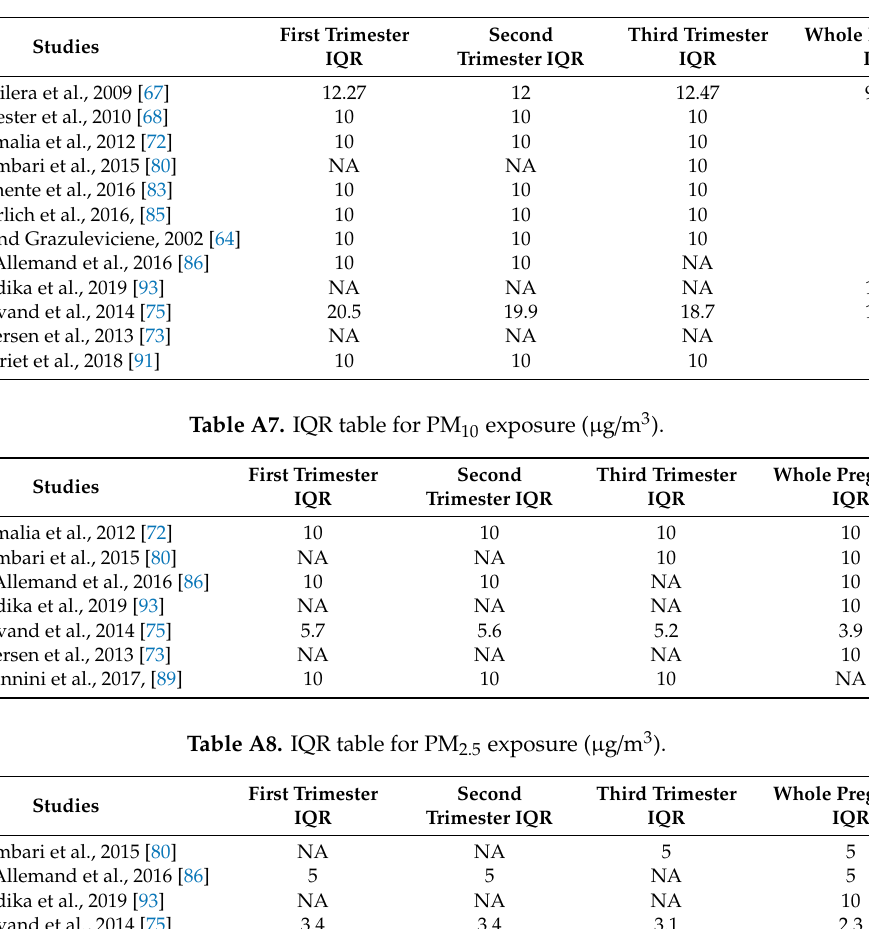
Table A6. Interquartile range (IQR) table for NO 2 exposure ( µ g / m 3 ).